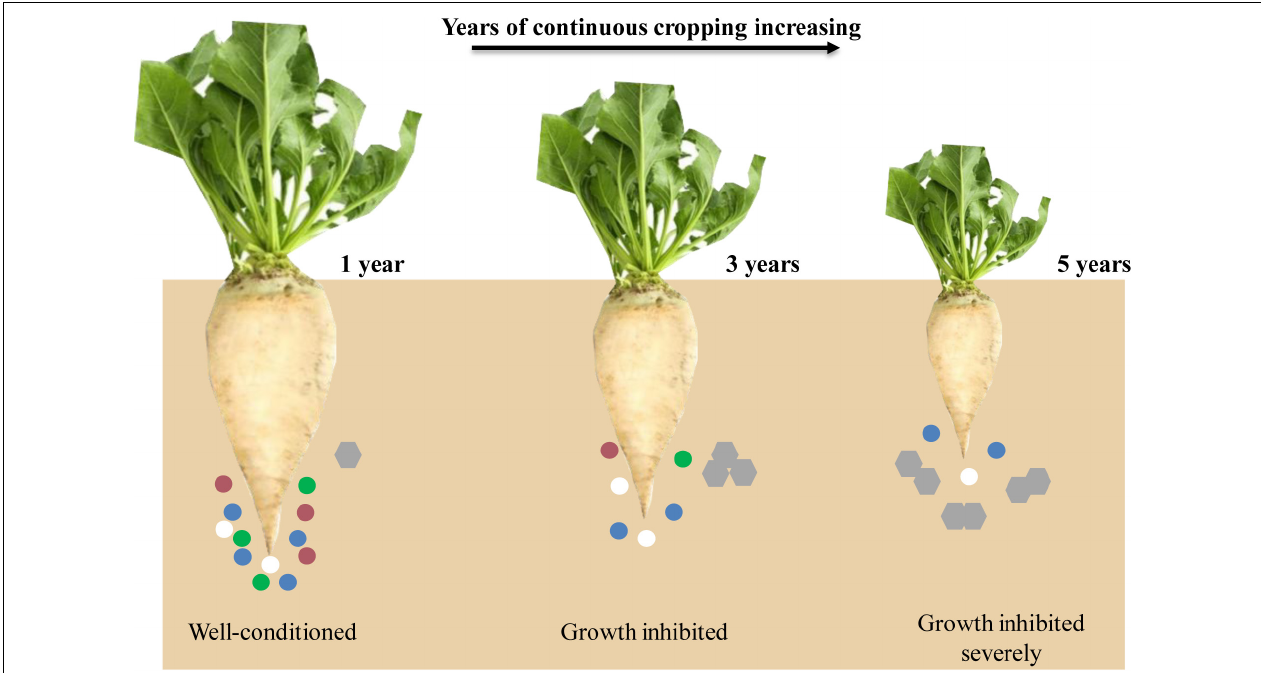
FIGURE 1 | A schematic representation of sugar beet root developmental for all 3 years. Circles and hexagons represent microbes and root exudates, respectively.